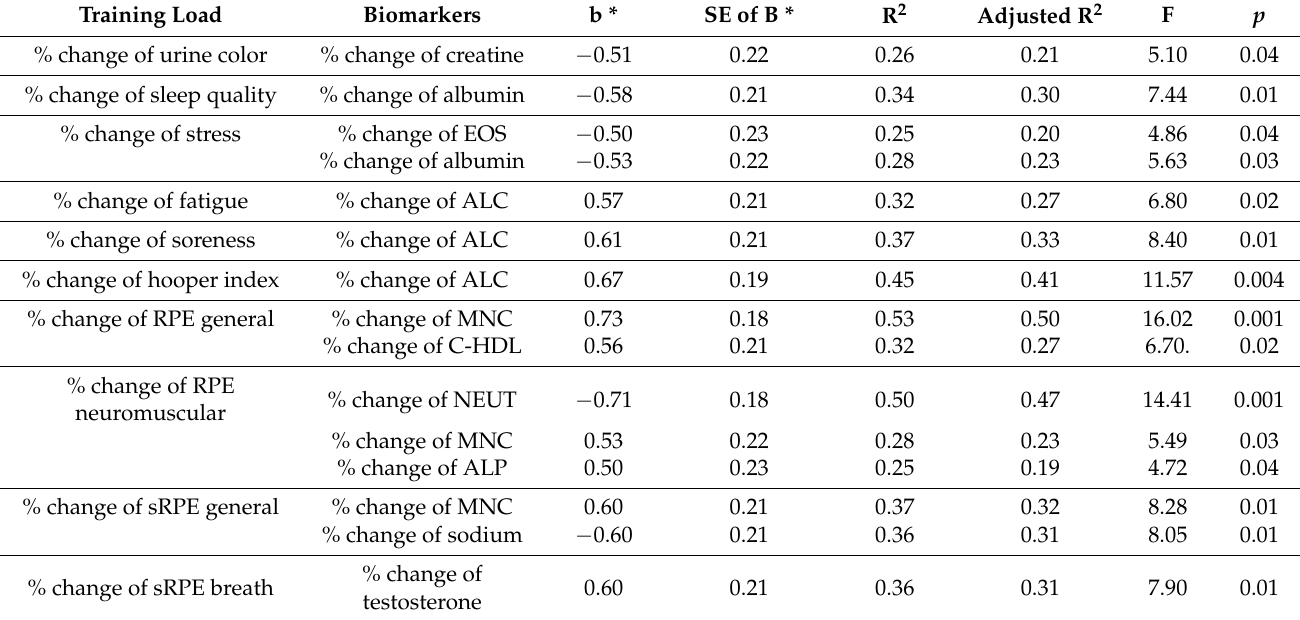
Table 6. Regression analysis for the percentage change of training loads based on percentage change on the remaining blood biomarkers. Training Load Biomarkers